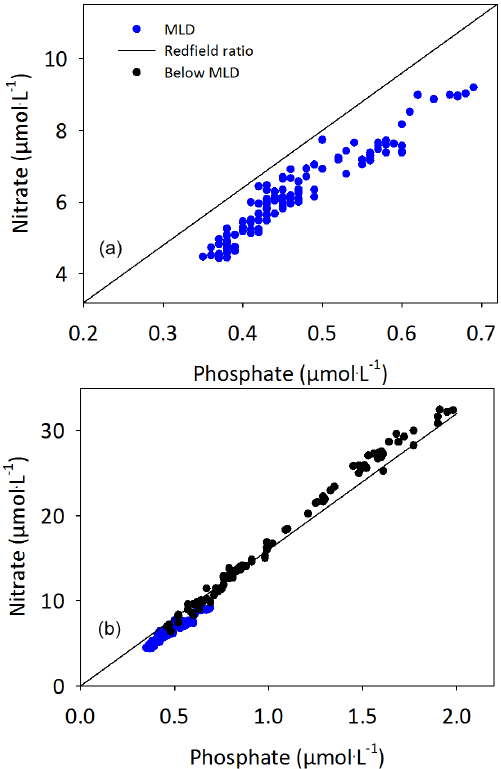
Figure 3. Ratio between ambient concentrations of nitrate and phosphate. The solid regression line is the Redfield ratio of 16 : 1. Data from within the surface mixed layer depth (MLD) are pre- sented in (a) , the regression of which provides a ratio of 13 . 9 : 1 and a phosphate excess of 72 ± 18nmol PL − 1 . Data from below the MLD, presented in (b) , were collected to a maximum depth of 1.4km. The regression of this data provided a ratio of 17 . 7 : 1.